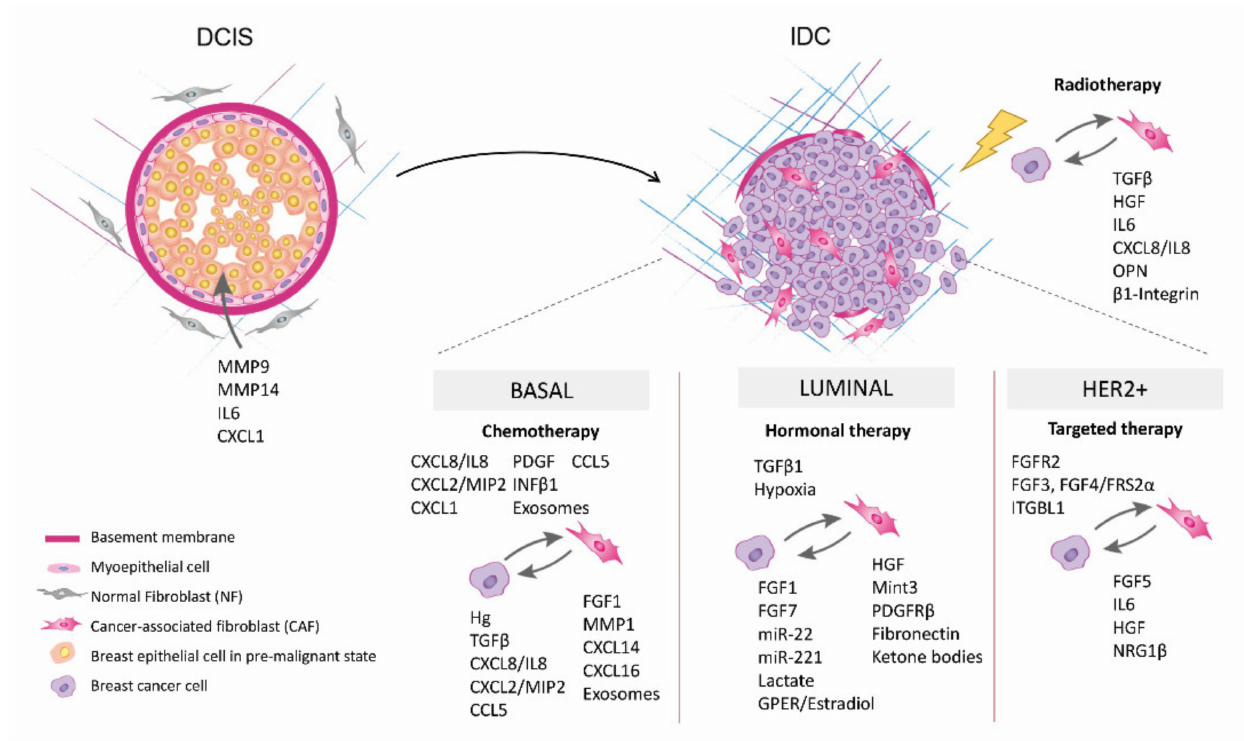
Figure 1. Tumor/stroma communication in ductal carcinoma in situ (DCIS) lesions ( left ) and tumor/stroma crosstalk in invasive breast cancer ( right ) favoring the resistant phenotype of breast cancer cells under radiotherapy, chemotherapy, hormonal and targeted therapy treatments. The main contributors to each situation are listed. For a list of all proteins names abbreviations please see Table